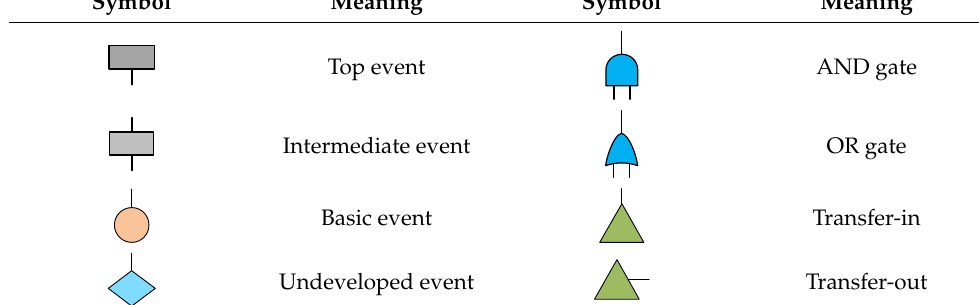
Table 5. Symbols used in the fault trees.